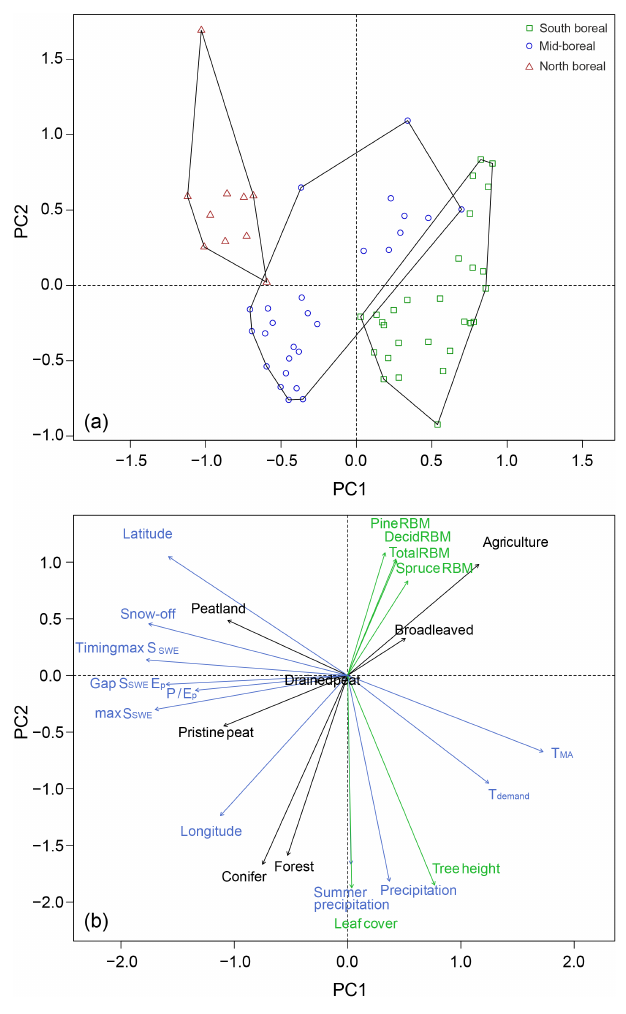
Figure 8. Principal component analysis with the catchment charac- teristics that are being compared with S r in the study. (a) Catch- ments plotted on PC1 and PC2, with boreal regions indicated. (b) Catchment characteristics with their loadings on PC1 and PC2; catchment characteristics are divided into three categories: climate (blue), vegetation characteristics (green) and land use types (black). Note that for readability the axis of the two plots are not the